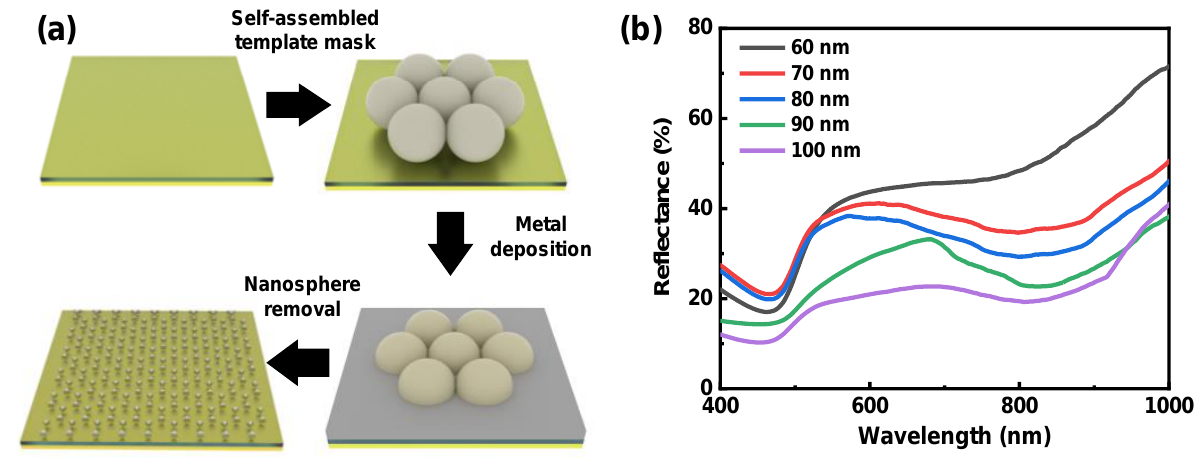
Figure 2. ( a ) Schematic fabrication processes for the Ag metasurfaces without ICP etching. ( b ) Meas- ured reflection spectra with different insulator gaps.